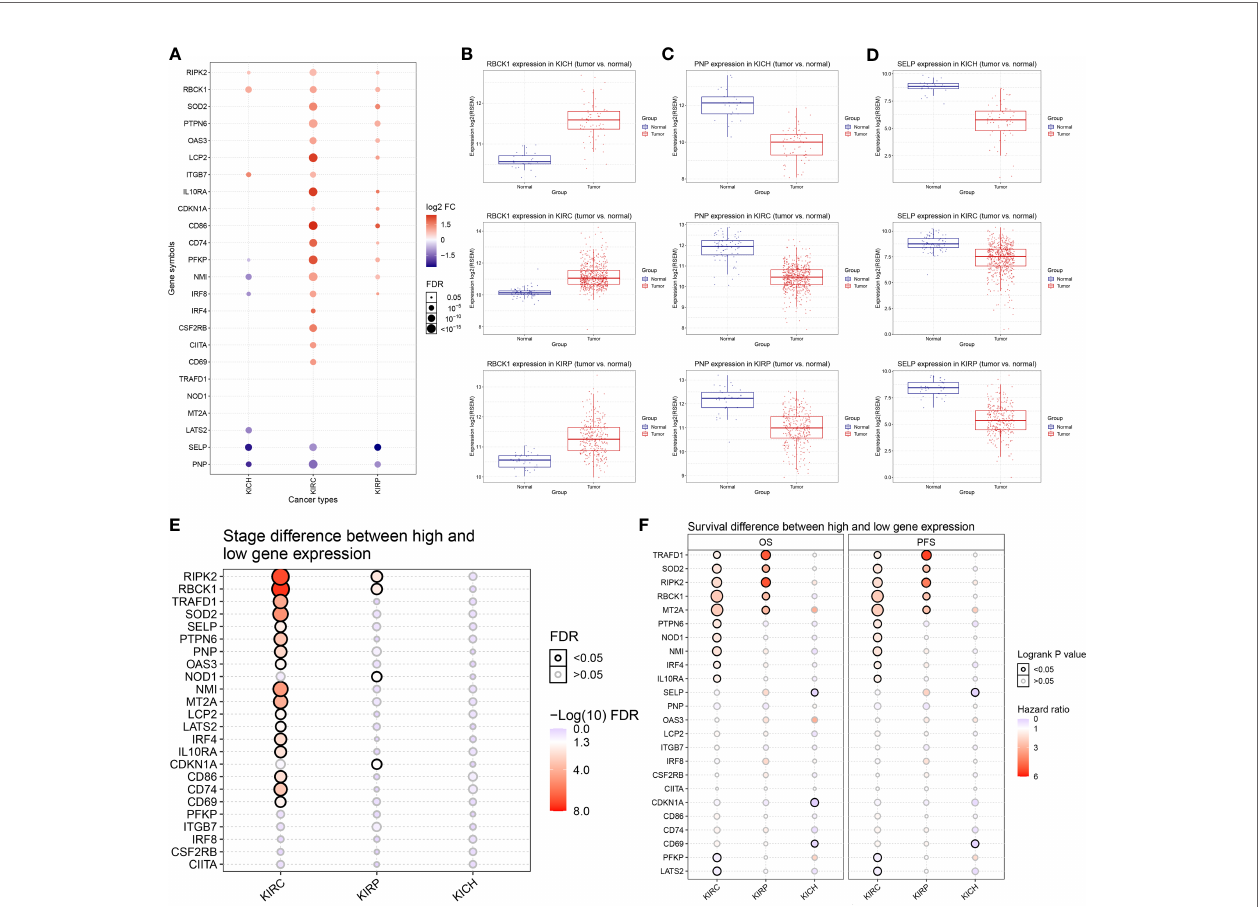
FIGURE 1 | Differentially expressed 24 IFN- g response genes and its association with clinical features of renal cell carcinoma (RCC). (A) We compared the mRNA expression in clear cell RCC (ccRCC) ( n = 530), papillary RCC (pRCC) ( n = 323), chromophobia RCC (chRCC) ( n = 91), and adjacent normal kidney tissues displayed using a bubble chart. The size of the circle represents statistical signi fi cance; red represents signi fi cantly high expression in tumor tissue and blue represents low. (B – D) Expressions of RBCK1, PNP, and SELP in RCC samples were observed in comparison with normal samples using unpaired t -test. (E) We summarized the difference of IFN- g response signatures of mRNA expression between clinical stages in ccRCC, pRCC, and chRCC using Wilcoxon non-parametric test. (F) The univariate Cox survival analysis emphasized the prognostic signi fi cance of TRAFD1, SOD2, RIPK2, RBCK1, and MT2A as cancer-promoting factors of ccRCC and